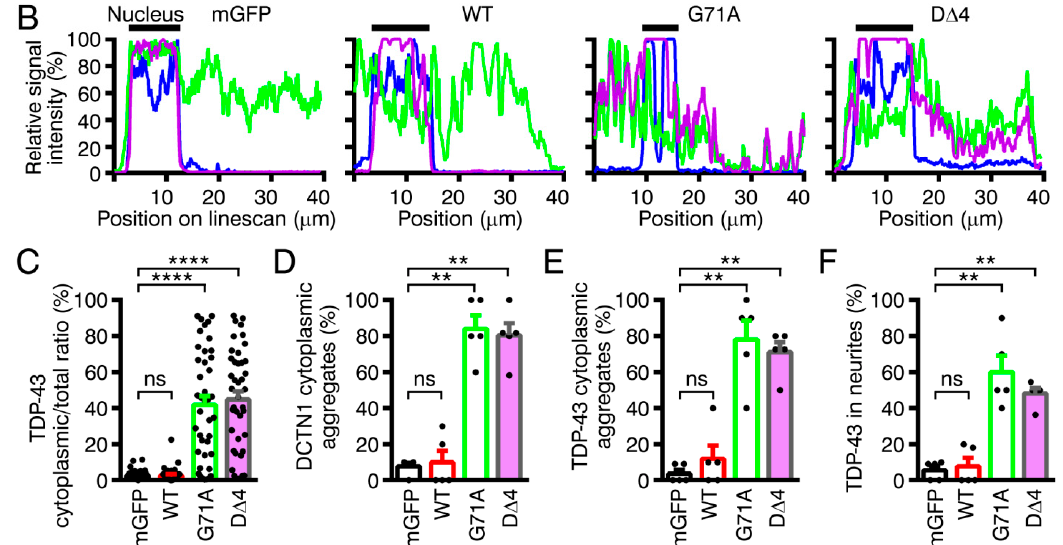
Figure 6. Human iPSC-based modeling of Perry disease. Coexpression of mutant DCTN1 tagged with mGFP and mCherry-tagged wild-type TDP-43 caused cytoplasmic mislocalization and aggregation of TDP-43 in neurons differentiated from NEUROG2 -inducible human iPSCs. The transfected cells were cultured for two days under nonstressed conditions, fixed, and subjected to confocal microscopy. ( A ) Maximum-intensity projections of deconvoluted z-stack confocal images of neurons coexpressing DCTN1 and TDP-43 constructs as indicated. Note the nuclear malformation (marked with white arrowheads; compare insets in the Hoechst 33,342 panels) in the DCTN1 G71A and TDP-43-coexpressing neuron. This phenomenon was often detected in DCTN1 G71A or D ∆ 4- and TDP-43-coexpressing neurons. Enlarged images of neurites show the regions marked with yellow arrowheads. Scale bars: 10 µ m (large panels); 5 µ m, (insets). ( B ) Linescan analyses in ( A ), along the white broken lines. ( C ) Quantification of cytoplasmic mislocalization of TDP-43. n = 43, 41, 41, and 42 (neurons) from left to right (four to five experiments). ( D – F ) Quantitative analyses of cytoplasmic aggregation of DCTN1 ( D ) and TDP-43 ( E ), and TDP-43 distribution in neurites ( F ). n = 5 experiments (10–12 neurons per experimental group). ** p < 0.01; **** p < 0.0001 compared to mGFP and mCherry-TDP-43-coexpressing control neurons, by